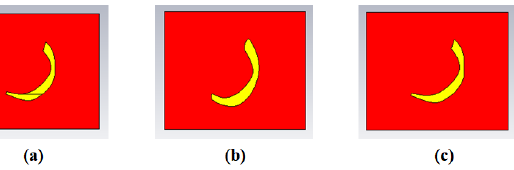
Figure 11. Designed letter P tag with various fonts with the same size of 28: ( a ) Arial; ( b ) Calibri; ( c ) Times New Roman (TNR).